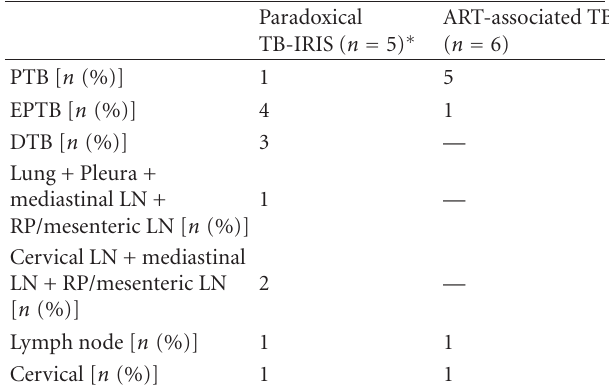
Table 9: Method of TB diagnosis in patients with TB-IRIS (at the time of IRIS) and ART-associated